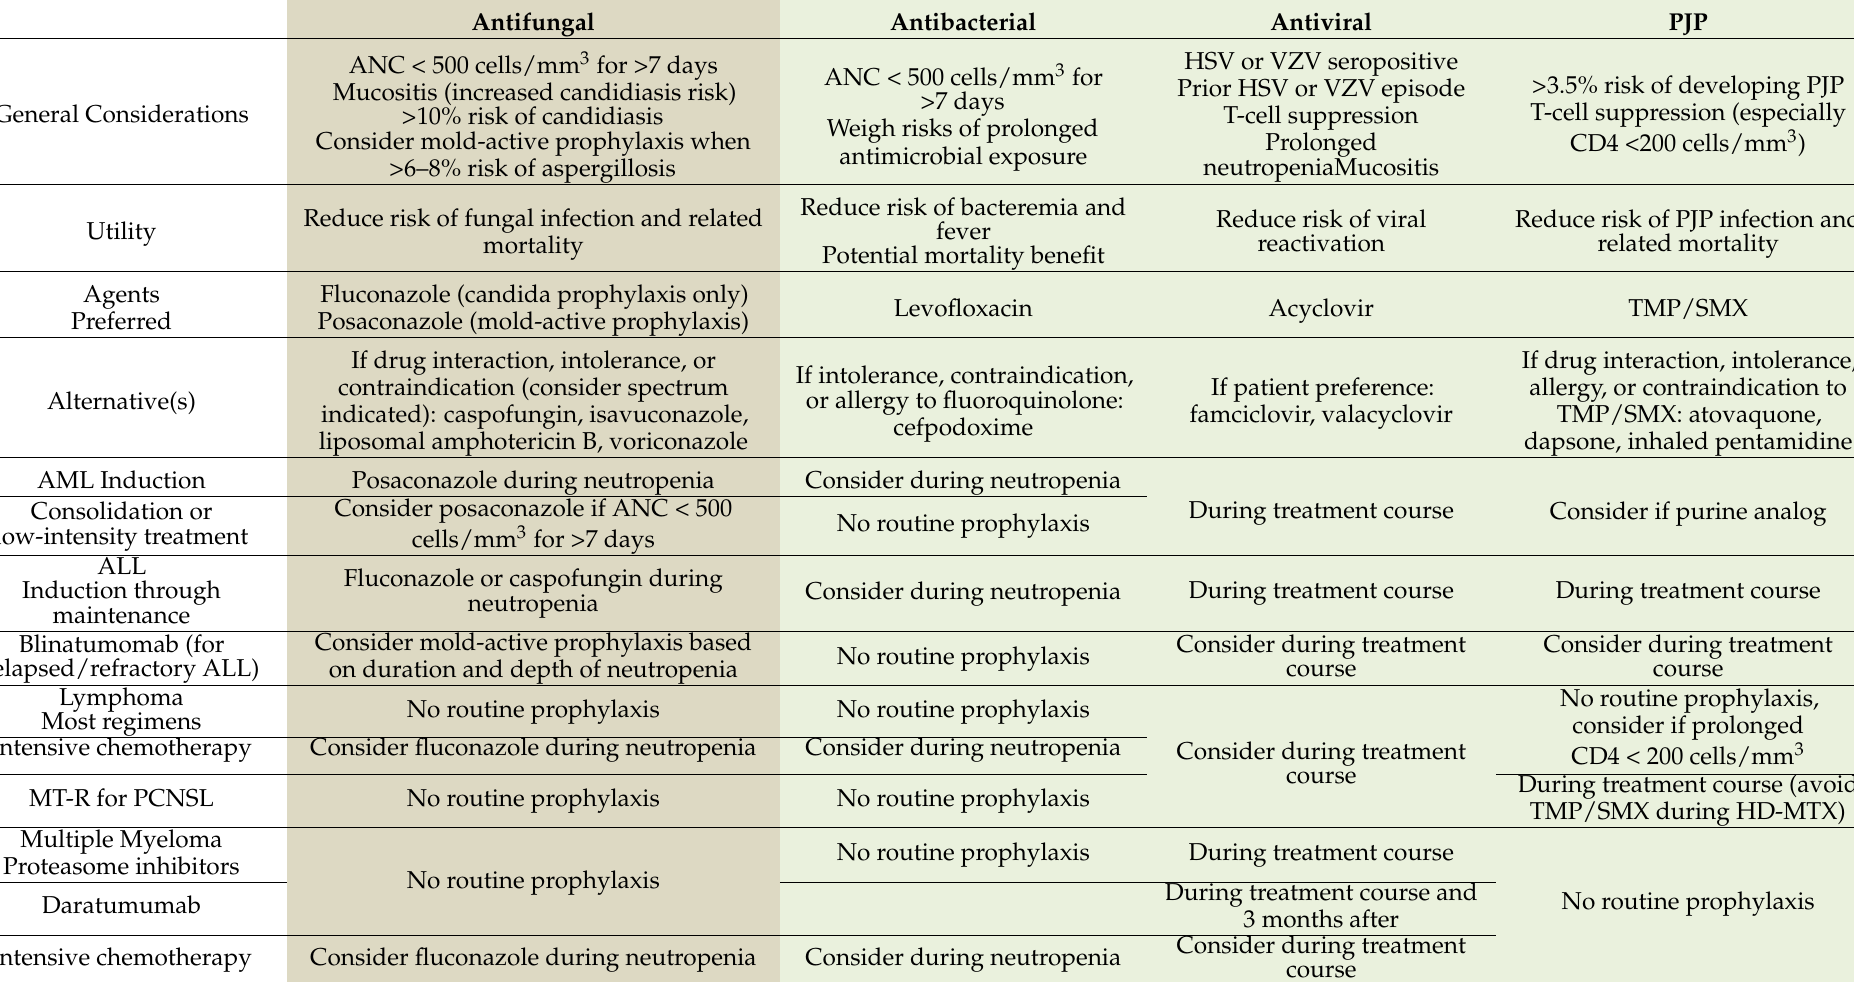
Table 1. Example of Incorporating Antifungal Stewardship into Prophylaxis for Hematology/Oncology Patients